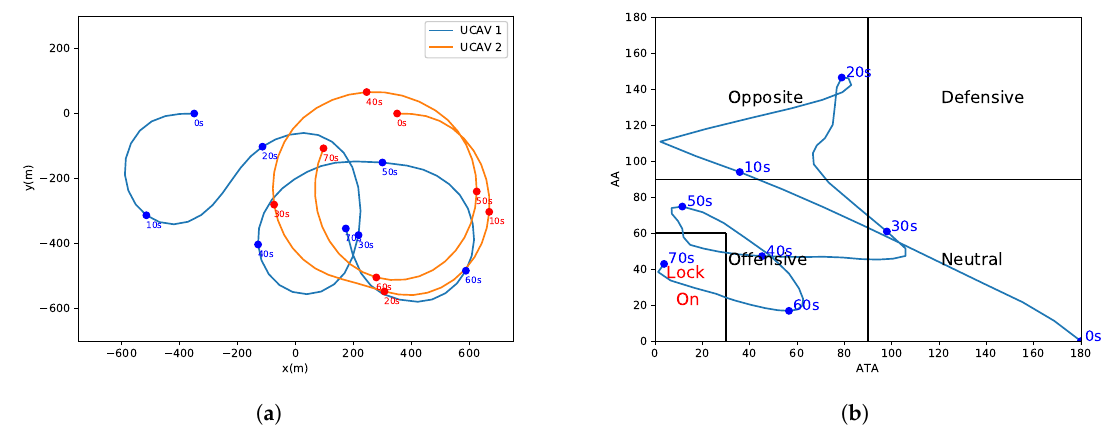
Figure 12. ( a ) Curve of the fly trajectory against RS-MADDPG strategy in the neutral initial situation. ( b ) Curve of the change of air combat situation against RS-MADDPG strategy in the neutral initial